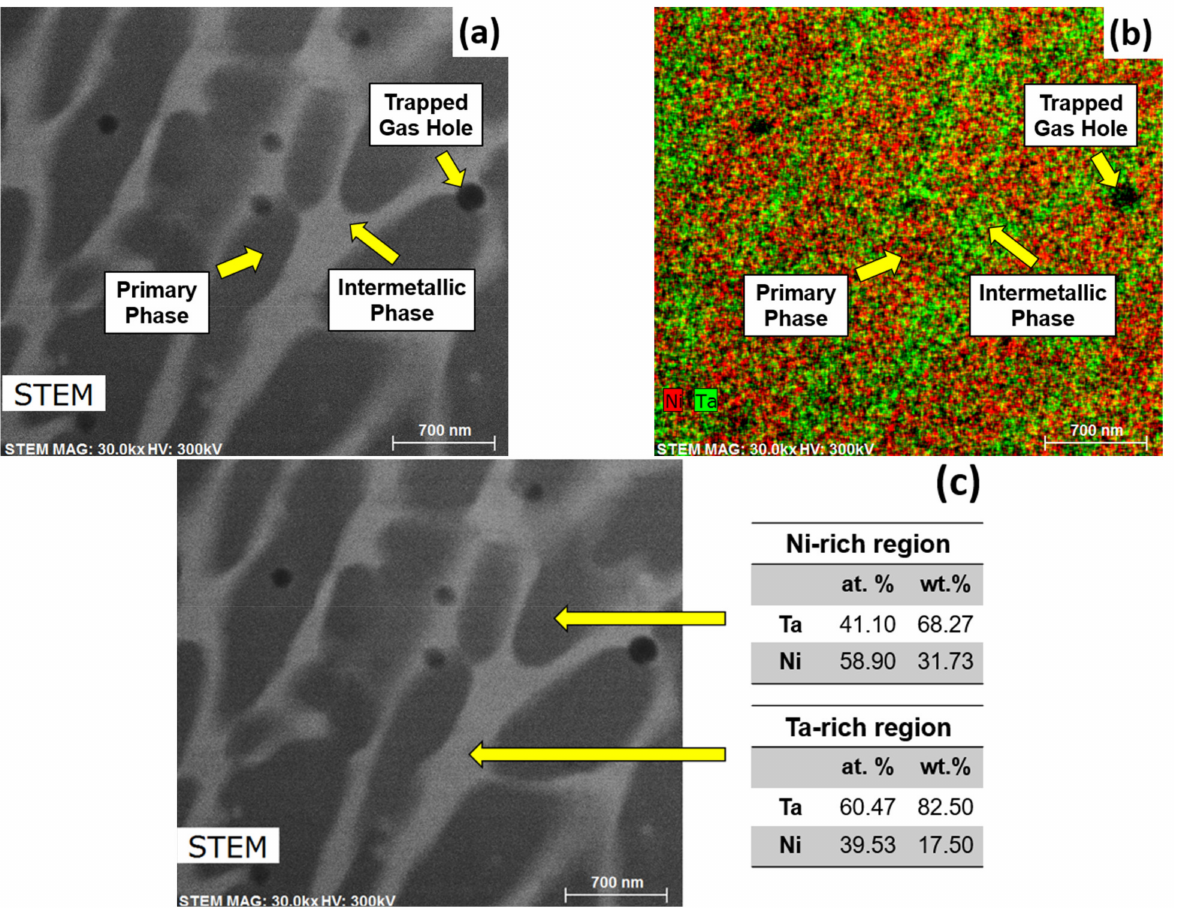
Figure 17. EDX mapping for phase composition and distribution of the as-fabricated specimen: